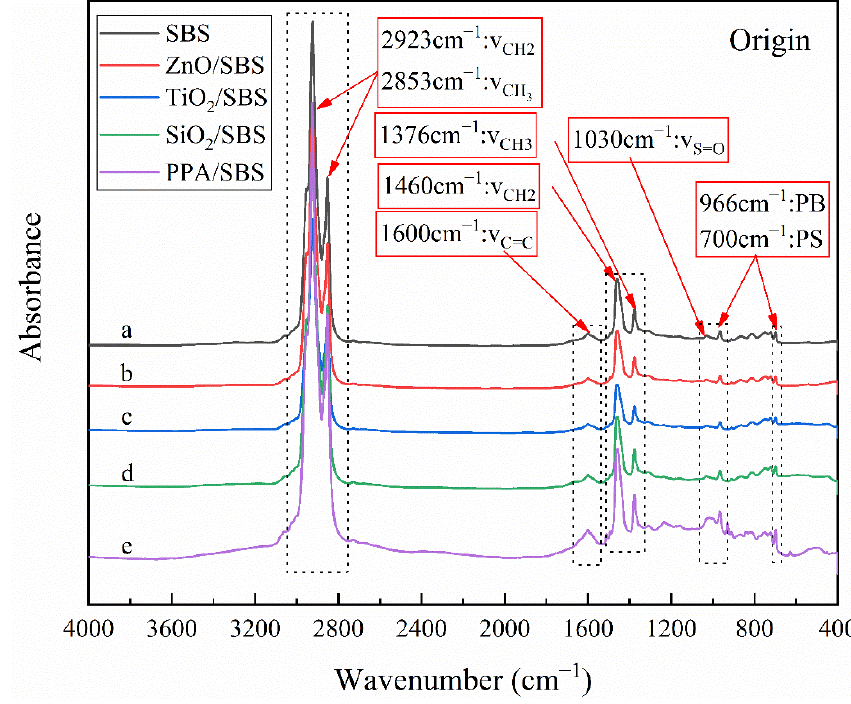
Figure 6. Infrared spectra of original high content SBS composite modified asphalt .